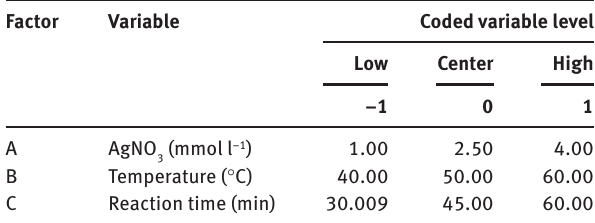
Table 1: Experimental domain with natural and coded values of independent variables used in Box-Behnken